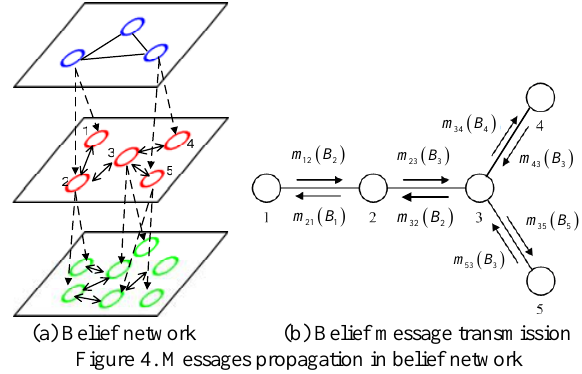
Figure 4. Messages propagation in belief